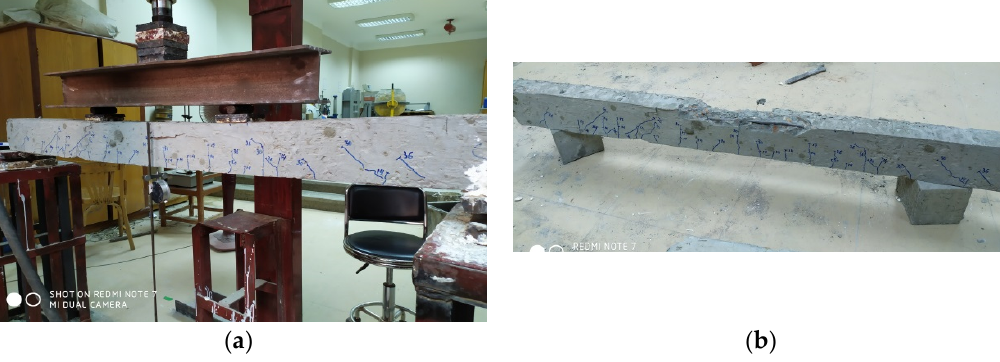
Figure 8. Crack pattern of the control beam B0 *: ( a ) crack pattern ( b ) the beam after the test.